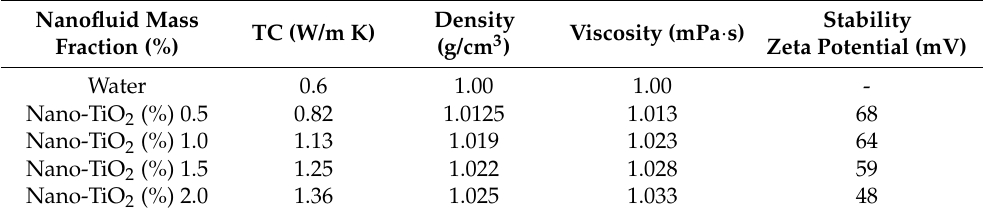
Table 6. The thermophysical specification of the tested nanofluids at 25 °C.